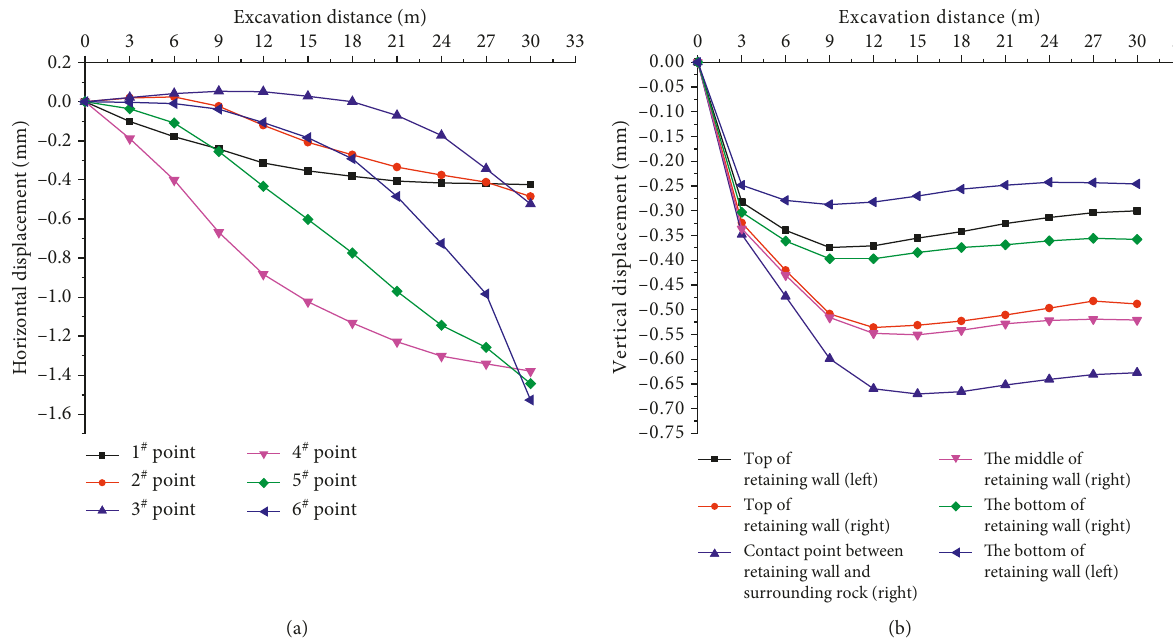
Figure 10: Displacement of the retaining wall at different excavation distances: (a) horizontal displacement; (b) vertical